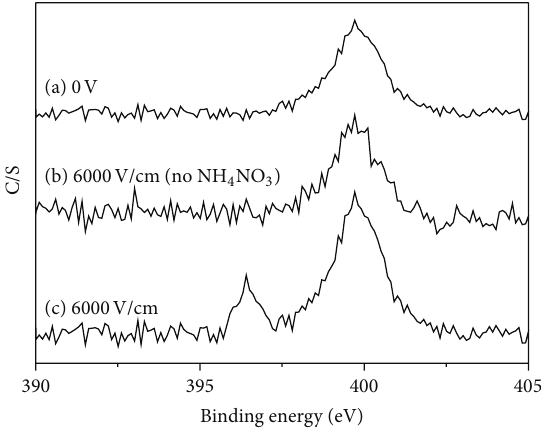
Figure 4: XPS of the N1s in composite film treated at 500 ∘ C for 1h: (a) 0V, (b) 6000 V/cm (no NH 4 NO 3 ) and (c) 6000 V/cm with addition of NH 4 NO 3 .